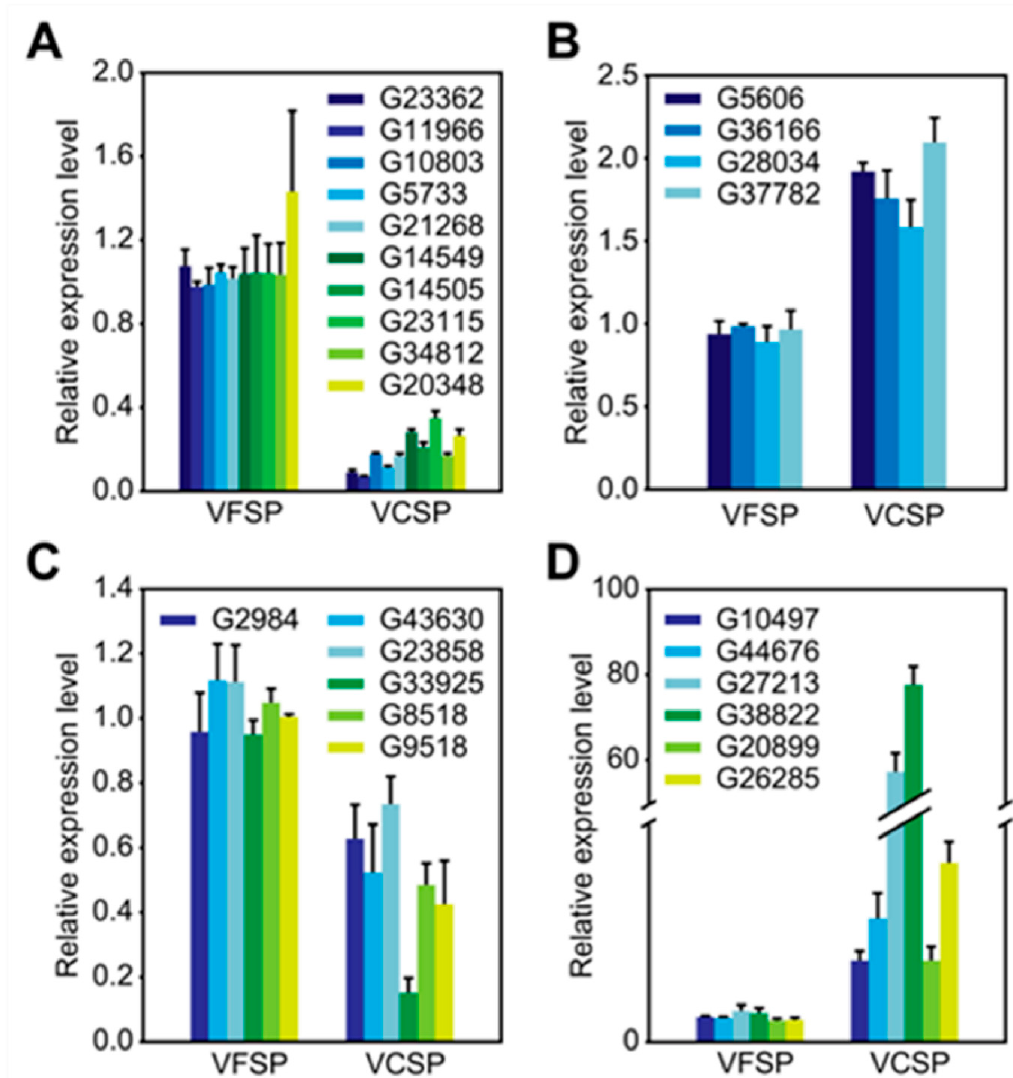
Figure 5. Validation of differentially expressed candidate genes. A , B : qRT-PCR analysis of ten upregulated genes ( A ) and four downregulated genes ( B ) in VFSP and VCSP leaves. C , D : qRT-PCR analysis of six upregulated genes ( C ) and six downregulated genes ( D ) in VFSP and VCSP storage roots. Three independent experimental replicates were analyzed for each sample, and data are indicated as the mean ± SD ( n = 3). Independent t -test was performed to check difference between VFSP and VCSP ( p < 0.05 or p < 0.01). All differentially expressed genes displayed significant differences between VFSP and VCSP at 0.05 confidence level.